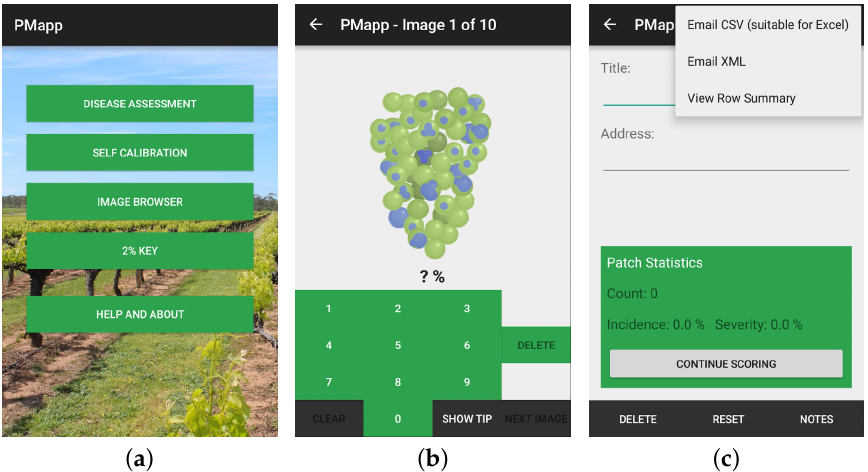
Figure 6. PMapp: ( a ) Main menu; ( b ) Assessment of the disease incidence degree in a bunch of grapes; ( c ) Data export.